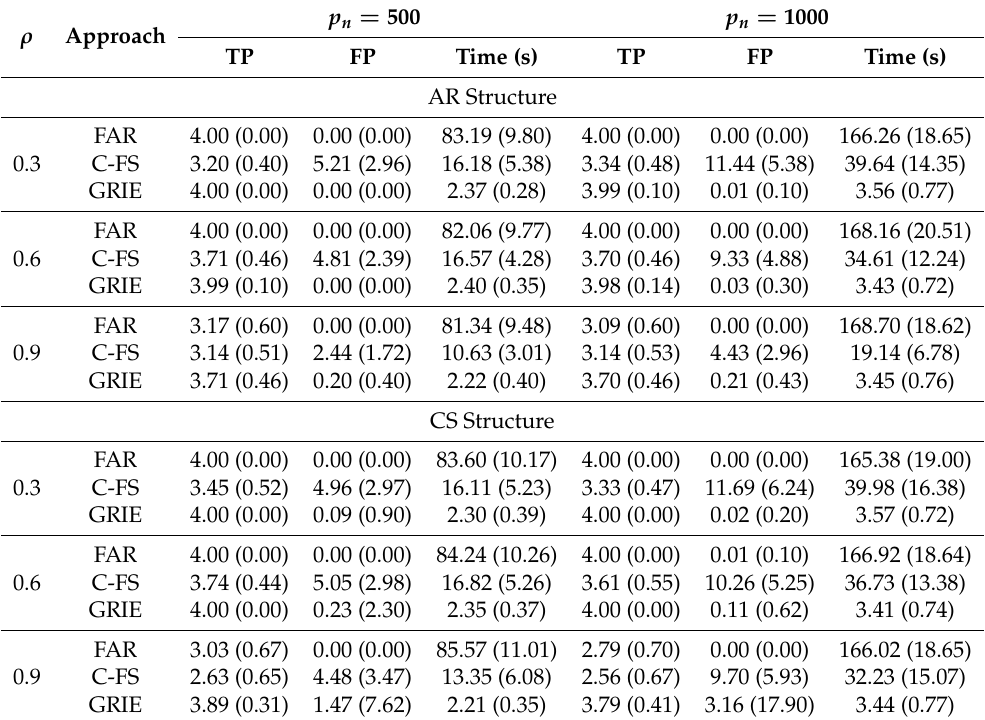
Table 1. Average number of true positive (TP), false positive (FP), and calculation time over 100 repe- titions and their robust standard deviations (in parentheses) of Example 1 with (cid:101) ∼ N ( 0,1 ) .